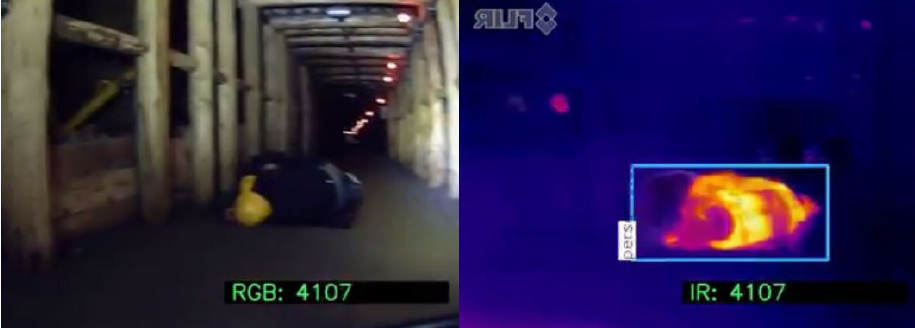
Figure 18. Human lying—no detection in RGB image, correct detection in the IR image with algorithm YOLO.